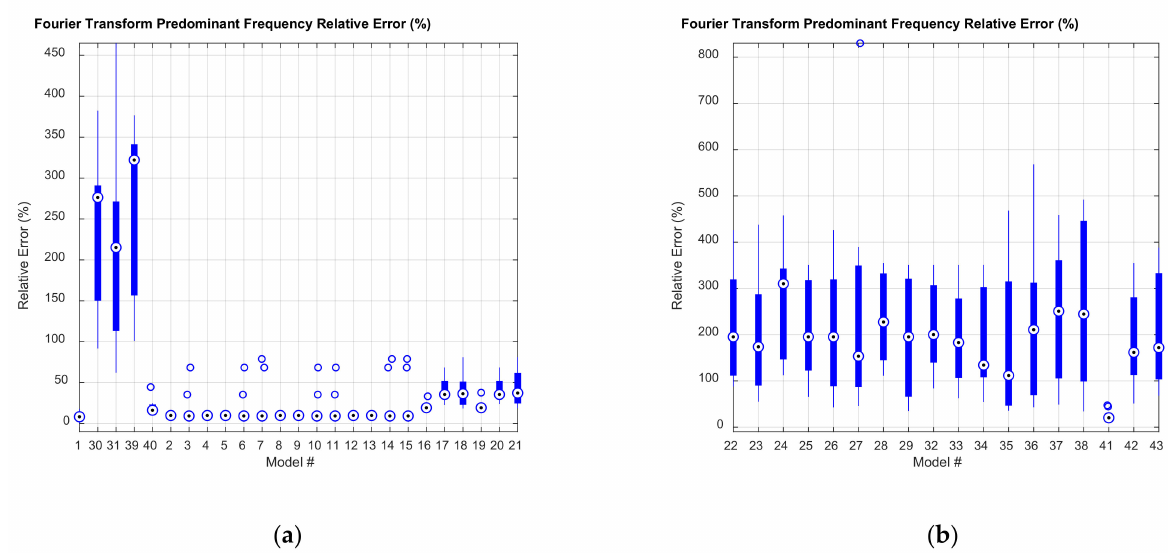
Figure 12. Median relative errors on the predominant frequency of the signal. ( a ) Models without vertical springs at the base; ( b ) models with vertical springs at the